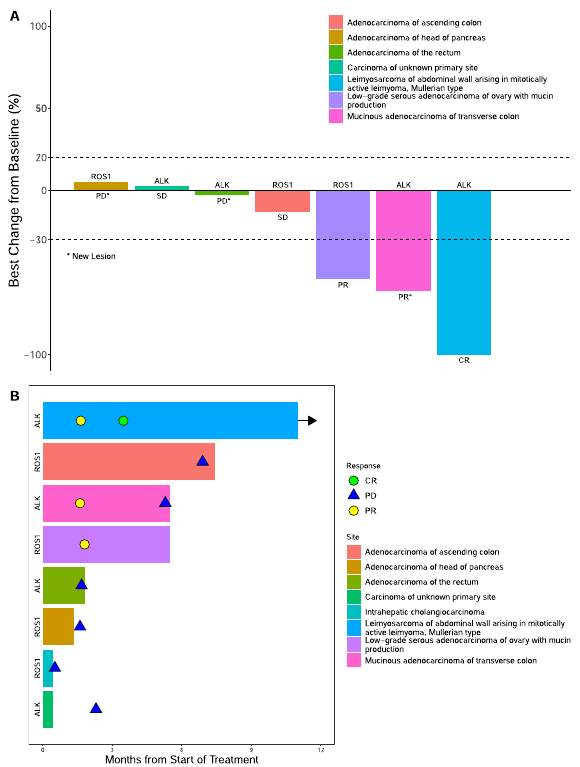
Fig. 1 Waterfall and Swimmer plot of responses and their durations. The waterfall plot shows responses for all patients who had response assessment ( A n = 7). One patient on subprotocol G (ROS1) is not included as treatment was discontinued during cycle one for toxicity and response was not evaluable. The Swimmer plot shows the duration of responses for all patients ( B n = 8). CR complete responses, PD progressive disease, PR partial response.